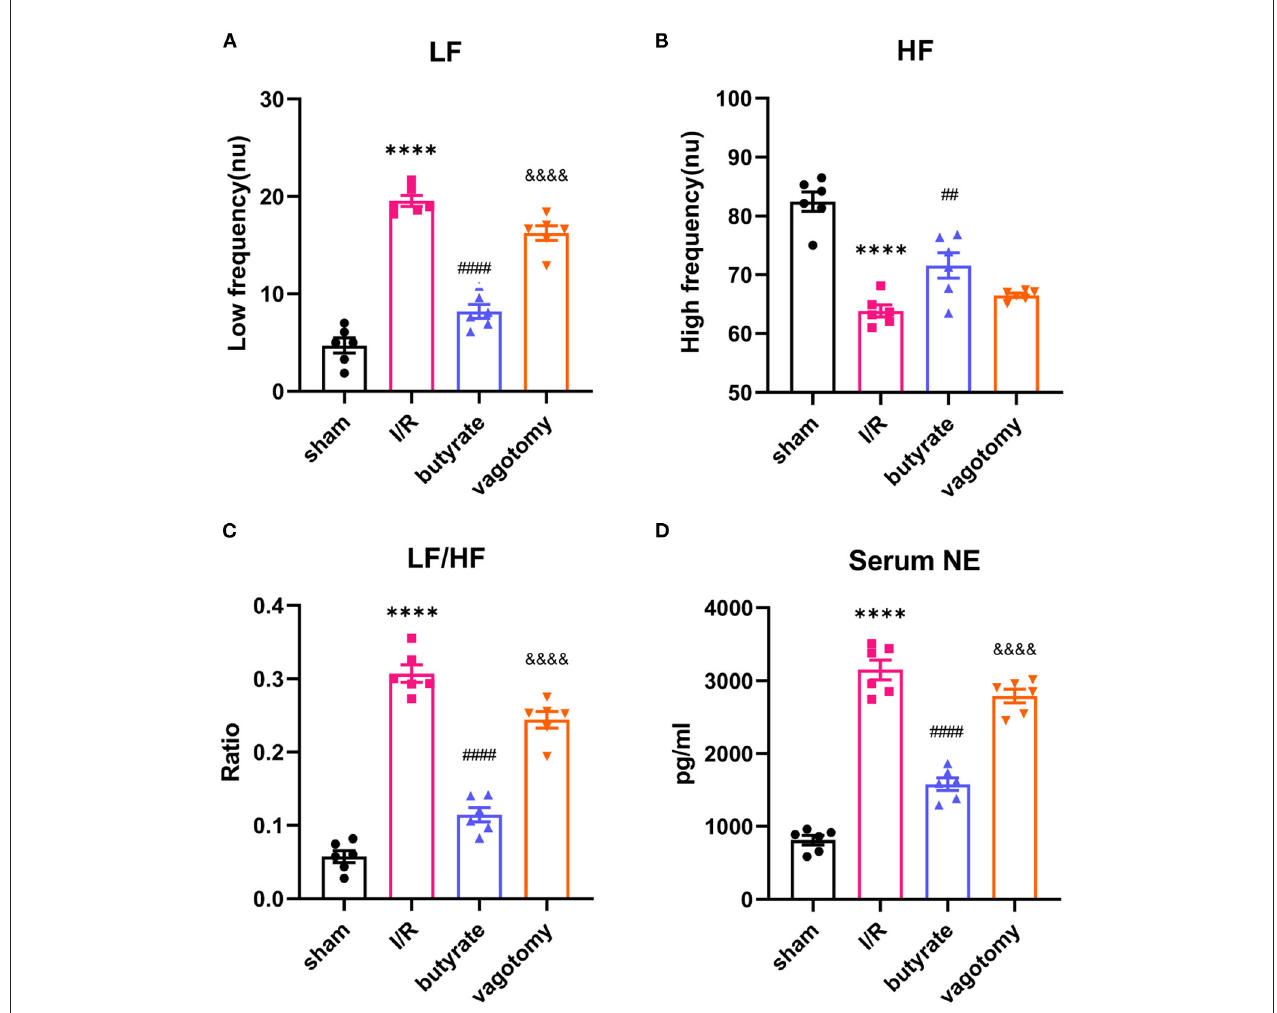
FIGURE 6 | Butyrate treatment reversed the high sympathetic tone after myocardial I/R, and vagotomy diminished this protective effect. (A) LF, (B) HF, and (C) LF/HF. (D) Serum NE. **** p < 0.0001 vs. sham group; ## p < 0.01, #### p < 0.0001 vs. I/R group; &&&& p < 0.0001 vs. butyrate group. LF, low frequency; HF, high frequency; NE, norepinephrine; I/R,